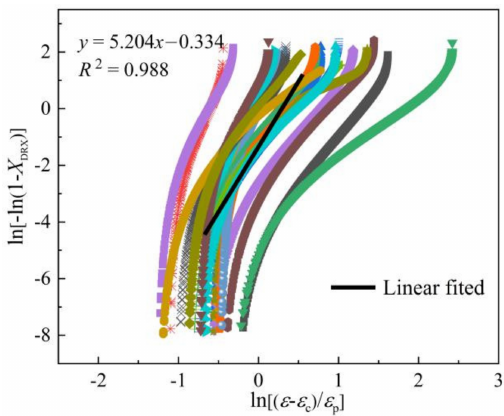
Figure 11. Linear fit of dynamic recrystallization material